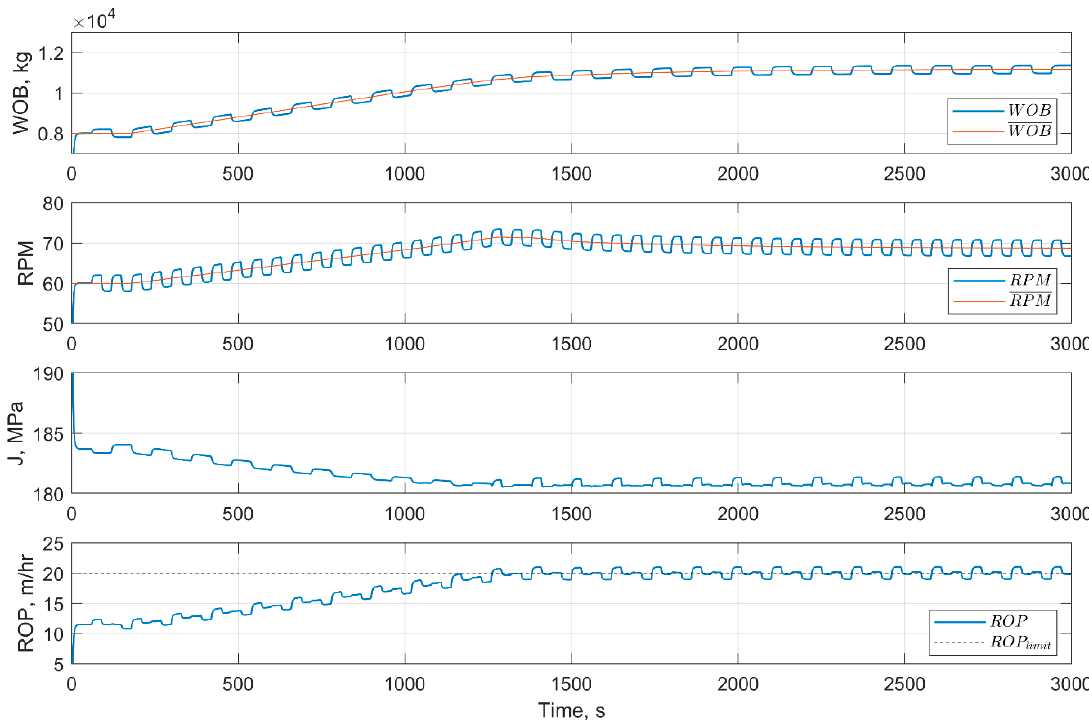
Figure 14. Simulation run 3, a scenario with a maximal limit imposed on the ROP .